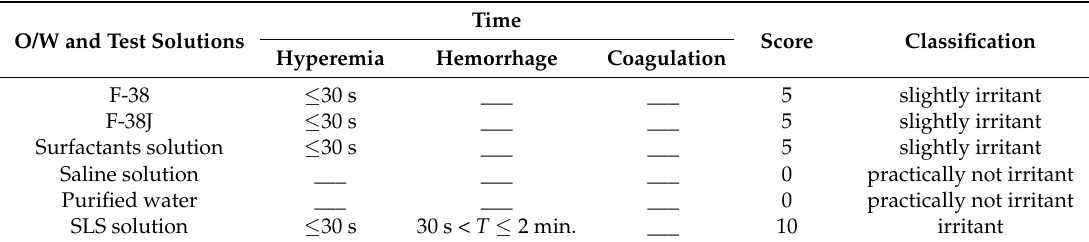
Table 5. Results for HET-CAM